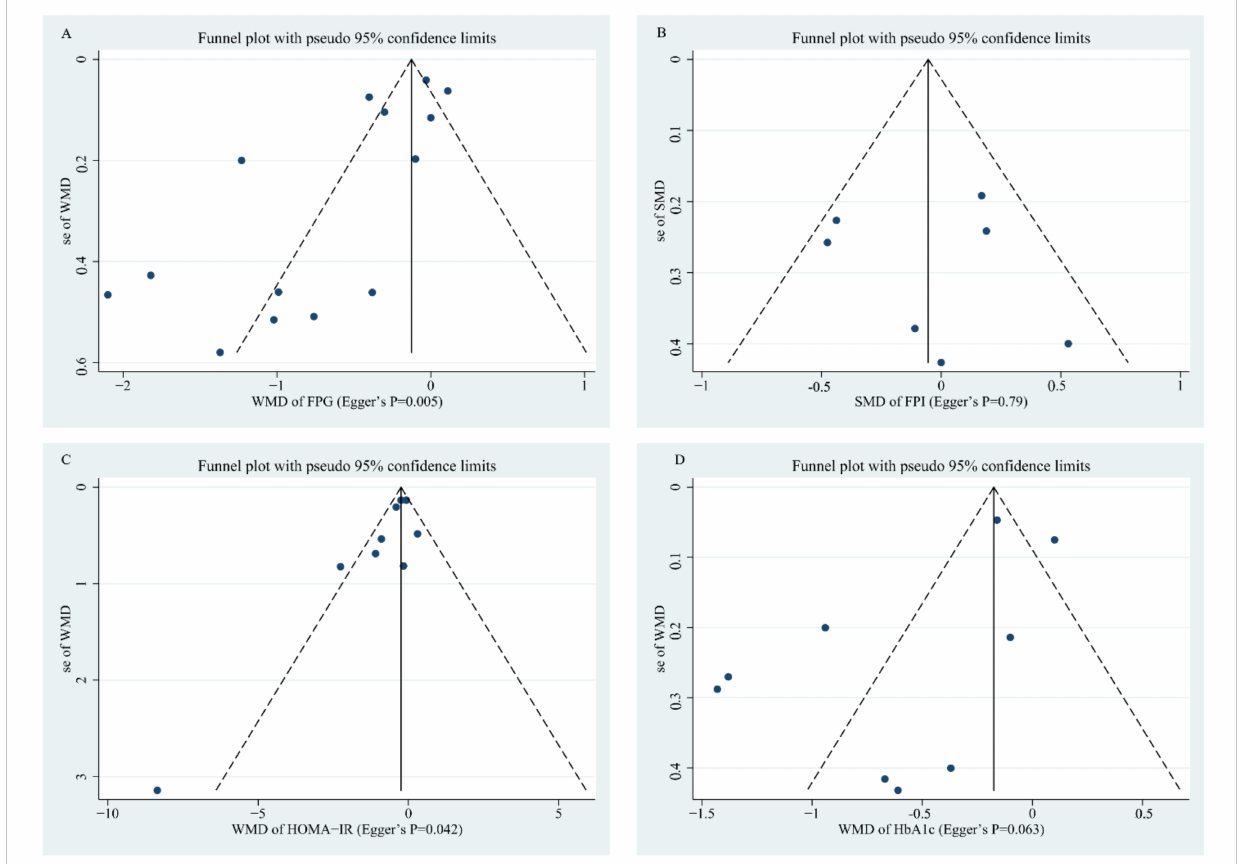
Figure 3. Funnel plot measuring the publication bias for the effects of whole grain consumption on